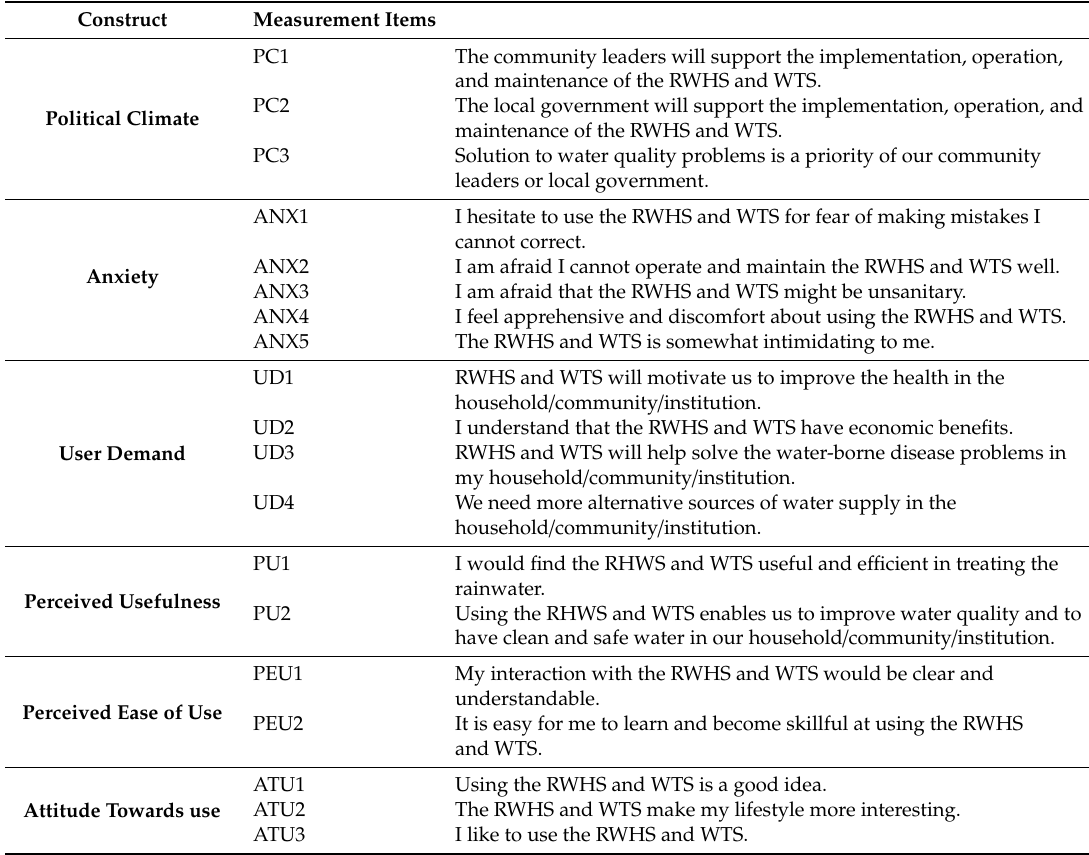
Table A4. C-TAM-TPB Questionnaire for